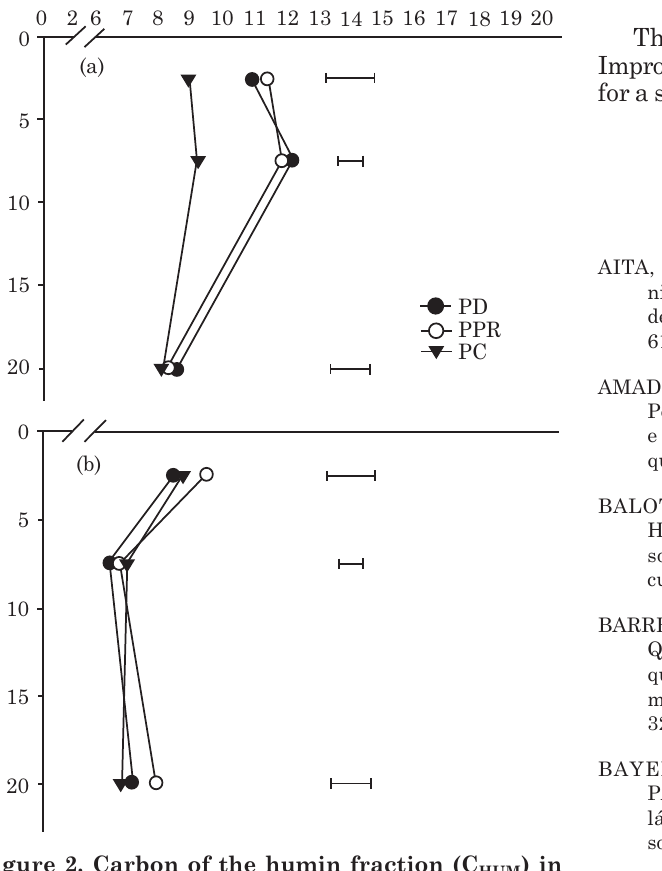
Figure 2. Carbon of the humin fraction (C HUM ) in Oxisol under different soil tillage systems, in summer (a) and winter sampling (b). NT, RT and CT are, respectively, no-tillage, reduced tillage and conventional tillage. The horizontal bars refer to the least significant difference (LSD) by the Tukey test